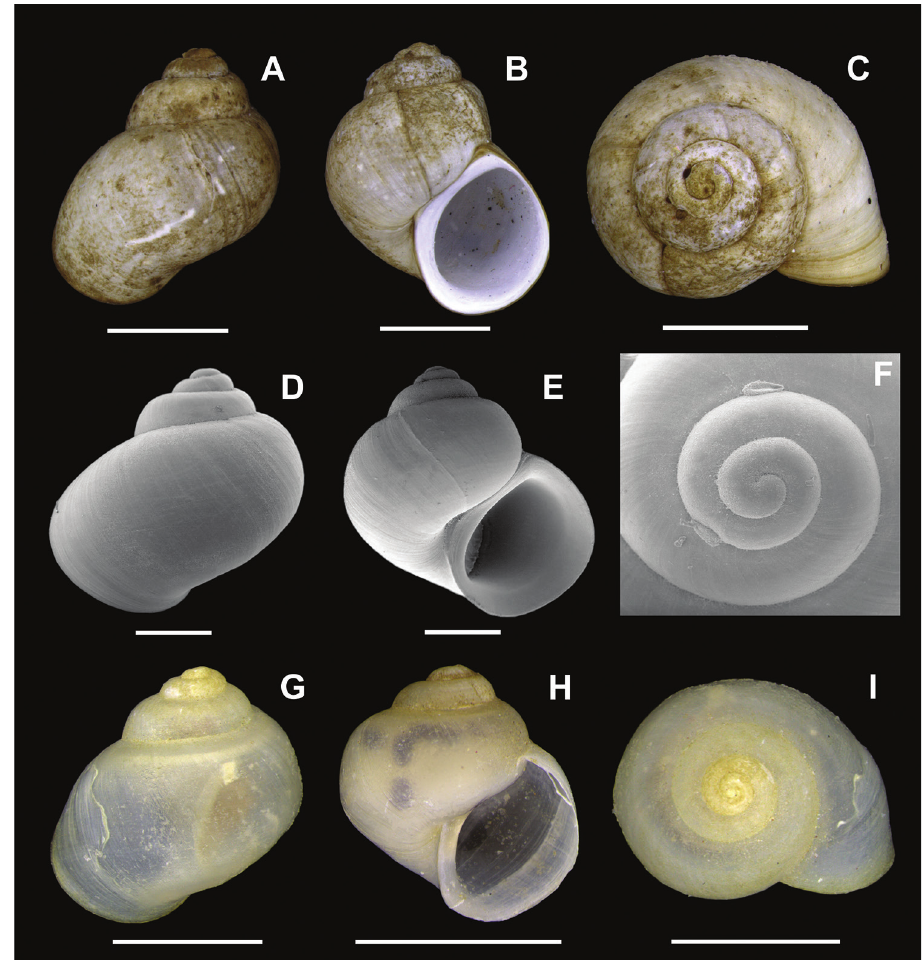
Figure 7. Potamolithus troglobius A (dorsal view) B (apertural view) C (apical view); Potamolithus aff. troglo- bius D (dorsal view) E (apertural view) F (apical view); Potamolithus sp. 8 G (dorsal view) H (apertural view) I (apical view). Scale bars: 1mm. (Photographs: LBR